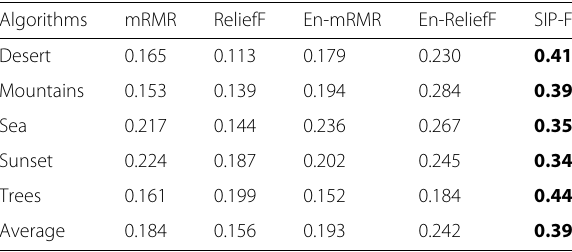
Table 1 Stability comparisons on MIML